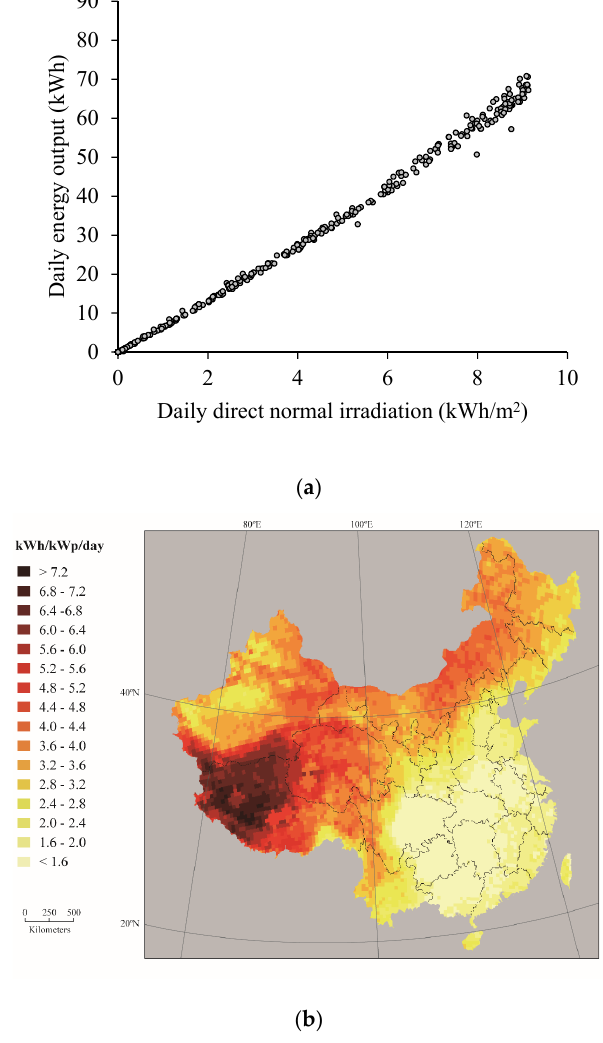
Figure 3. ( a ) Daily energy output plotted as a function of the daily direct normal irradiation during a whole year; ( b ) Estimation of the final yield when applying the present HCPV technique in China based on the performance of the present HCPV system in this investigation.